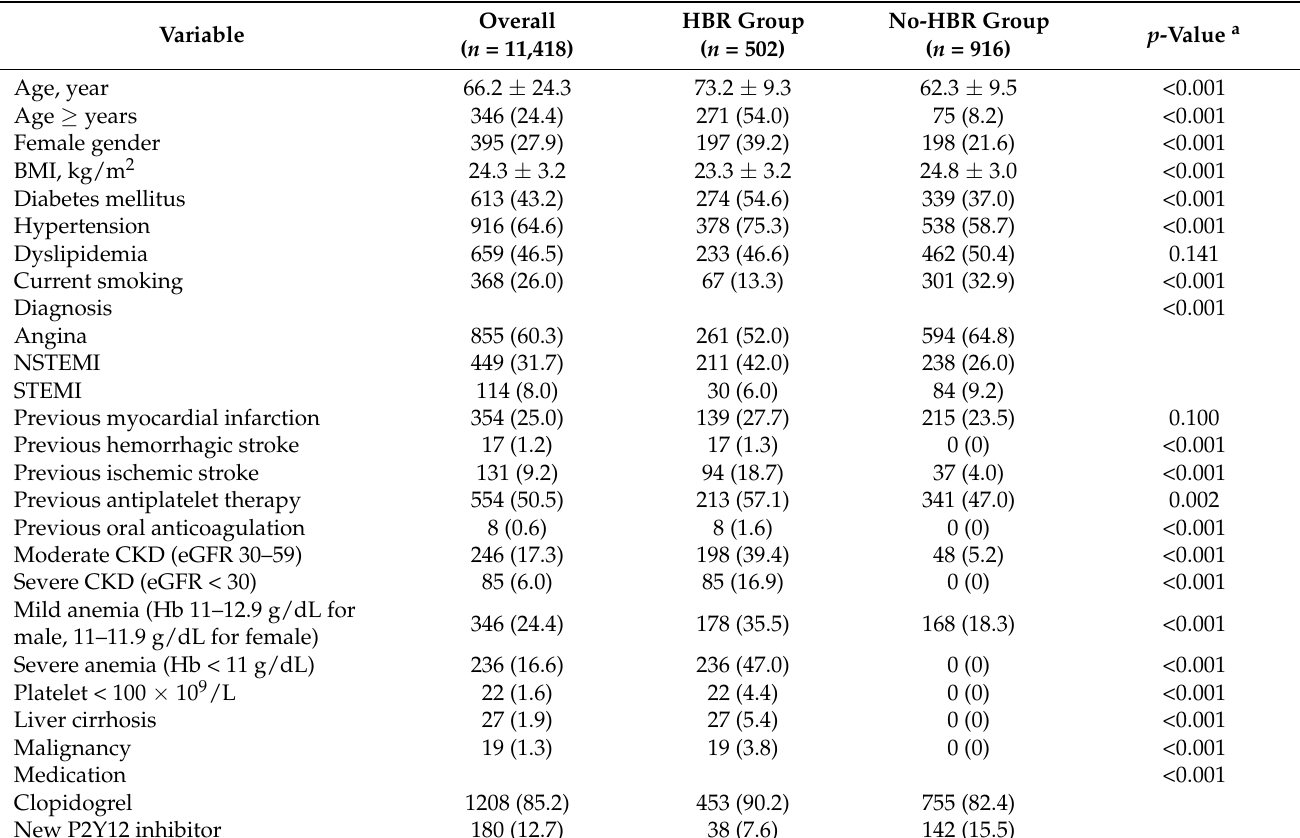
Table 1. Baseline